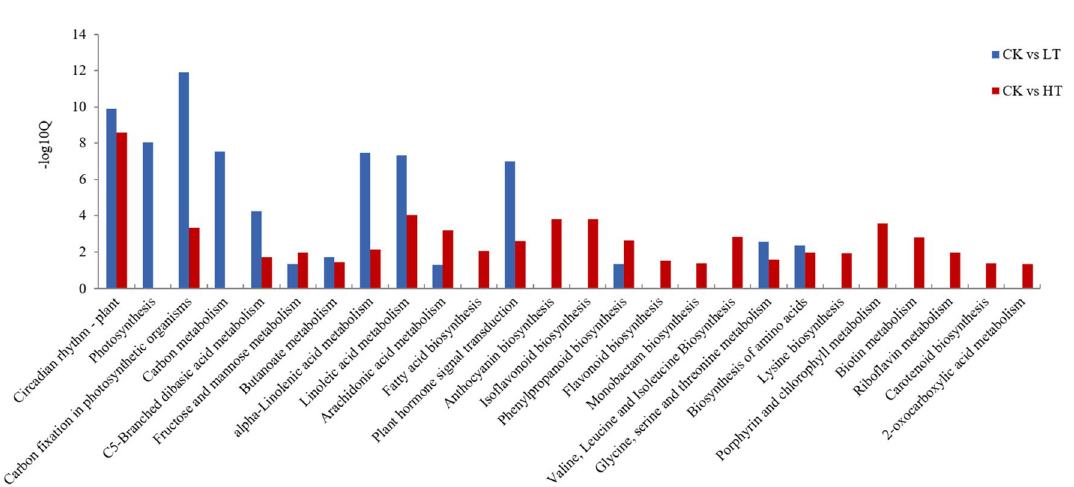
Figure 4. Gene Ontology (GO) functional classification analysis. The differentially expressed genes were classified into 50 categories, and the figure shows only those 20 categories with more than 200 differentially expressed genes.